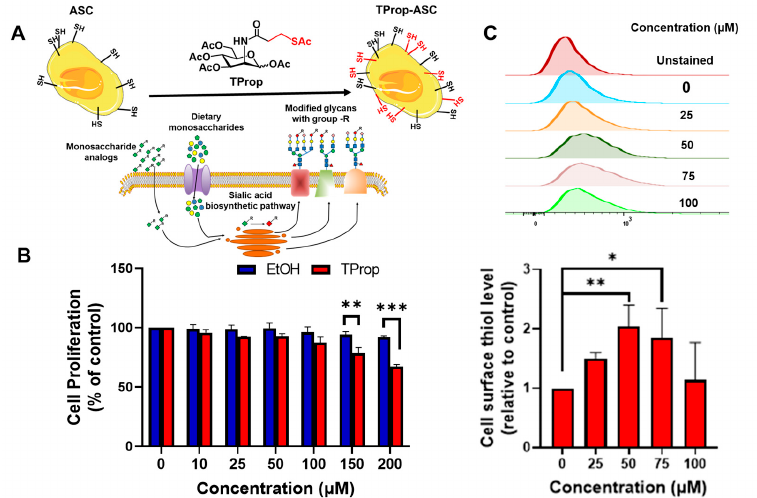
Figure 1. ( A ) Overview of MGE: ASCs are incubated with TProp resulting in incorporation into cell-surface displayed sialoglycans, thereby increasing the cell surface expression of thiol groups. ( B ) Cellular metabolic activity was determined by the MTT metabolic assay after 3 days of incuba-